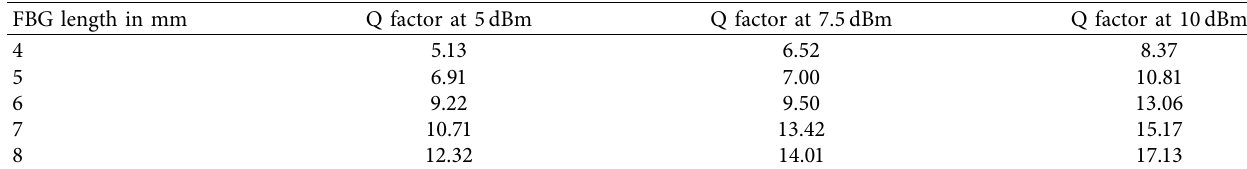
Table 3: Q-factor results for 3 FBG+DCF linear Gaussian apodization simulation models.